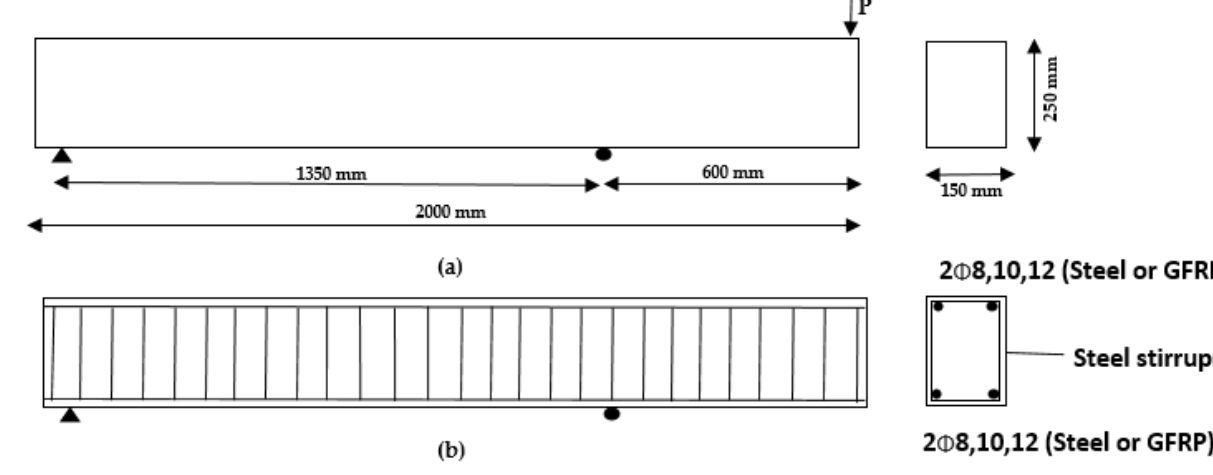
Figure 1. Details of concrete beams: ( a ) concrete dimensions of tested beam and ( b ) longitudinal reinforcement configuration.